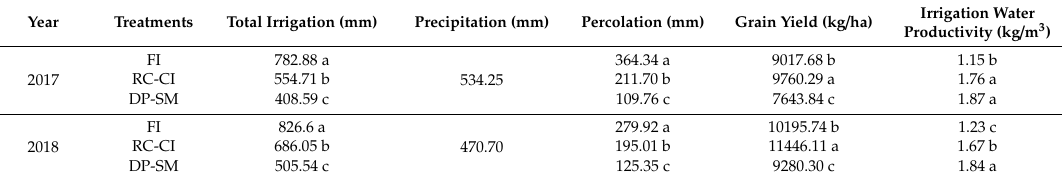
Table 3. Irrigation, percolation and rice yield of 2017 and 2018.